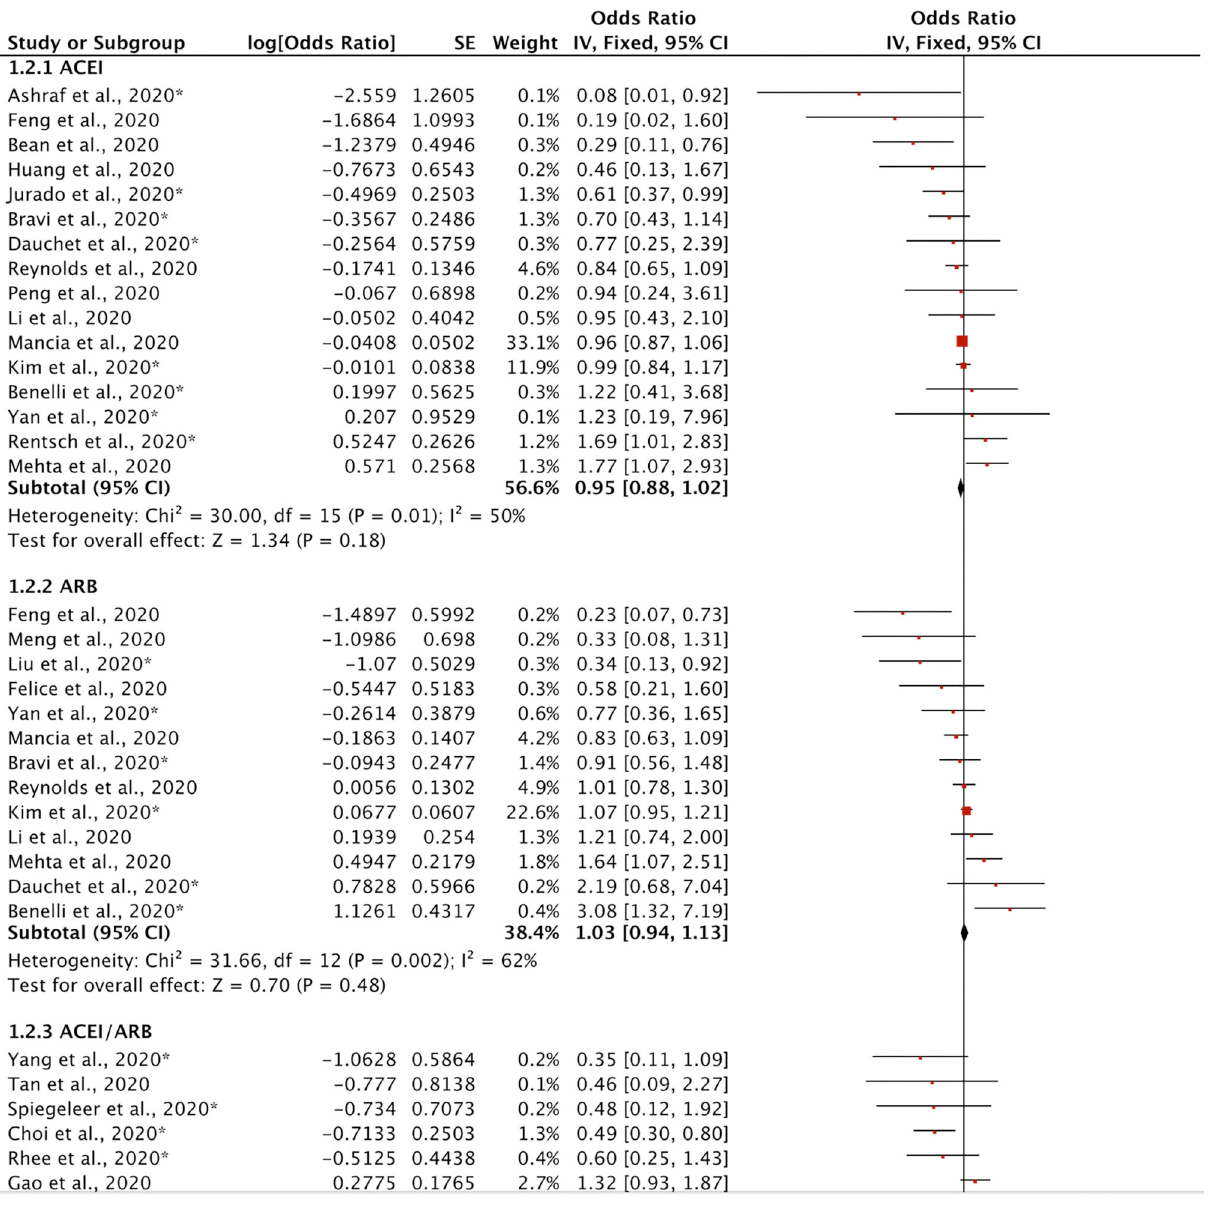
FIGURE 3 | Forest plot showing the effects of ACEIs and ARBs on the severity of COVID-19. SE, standard error; IV, inverse variance; df, degrees of